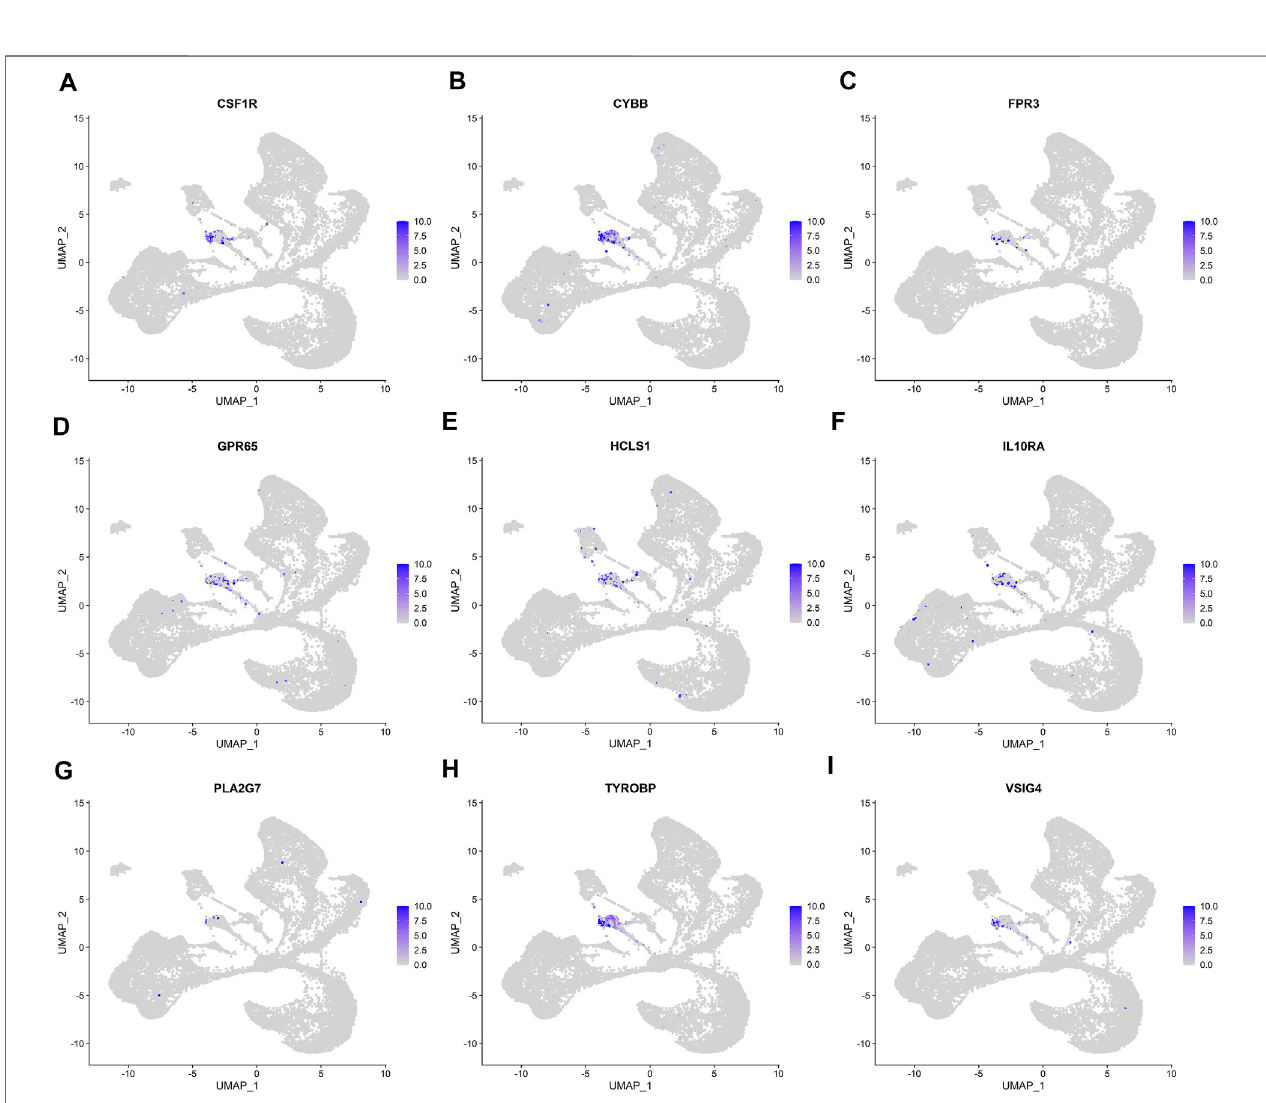
FIGURE 6 | UMAP plots of the expression and distribution of nine real hub genes for each cell cluster. (A – I) Expression distribution of CSF1R, CYBB, FPR3, GPR65, HCLS1, IL10RA, PLA2G7, TYROBP, and VSIG4 in different cell clusters in single-cell UMAP plots.